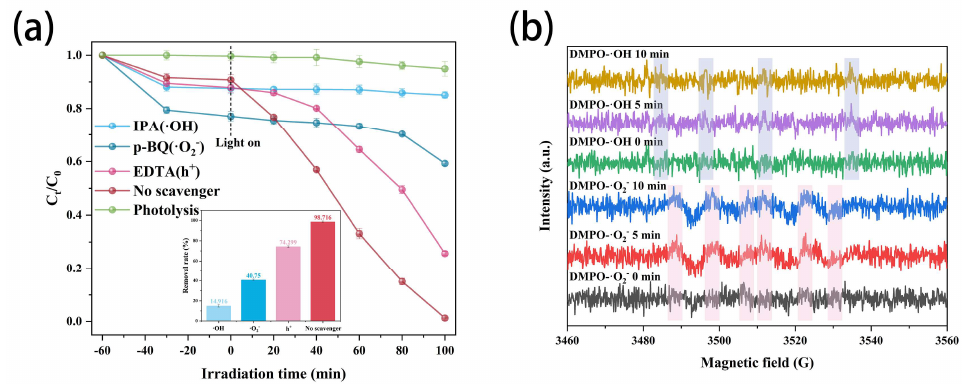
Figure 11. ( a ) ATZ degradation under radical capture conditions with 2BBOS. ( b ) ESR spectra of 2BBOS in Xe-lamp light.